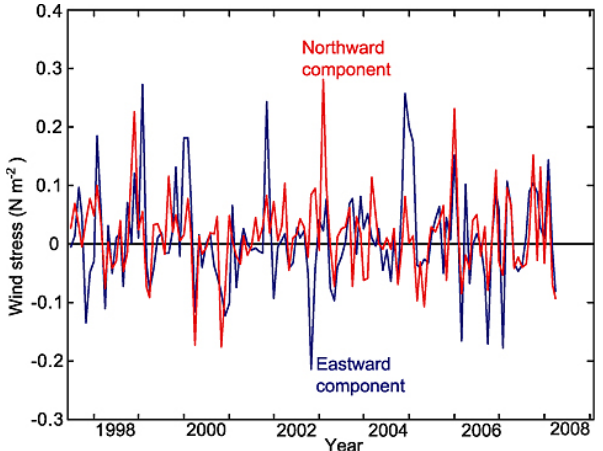
Fig. 9. Monthly averaged eastward (blue) and northward (red) com- ponents of the wind stress at position 64 ◦ N, 11 ◦ W from July 1997 to April 2008.